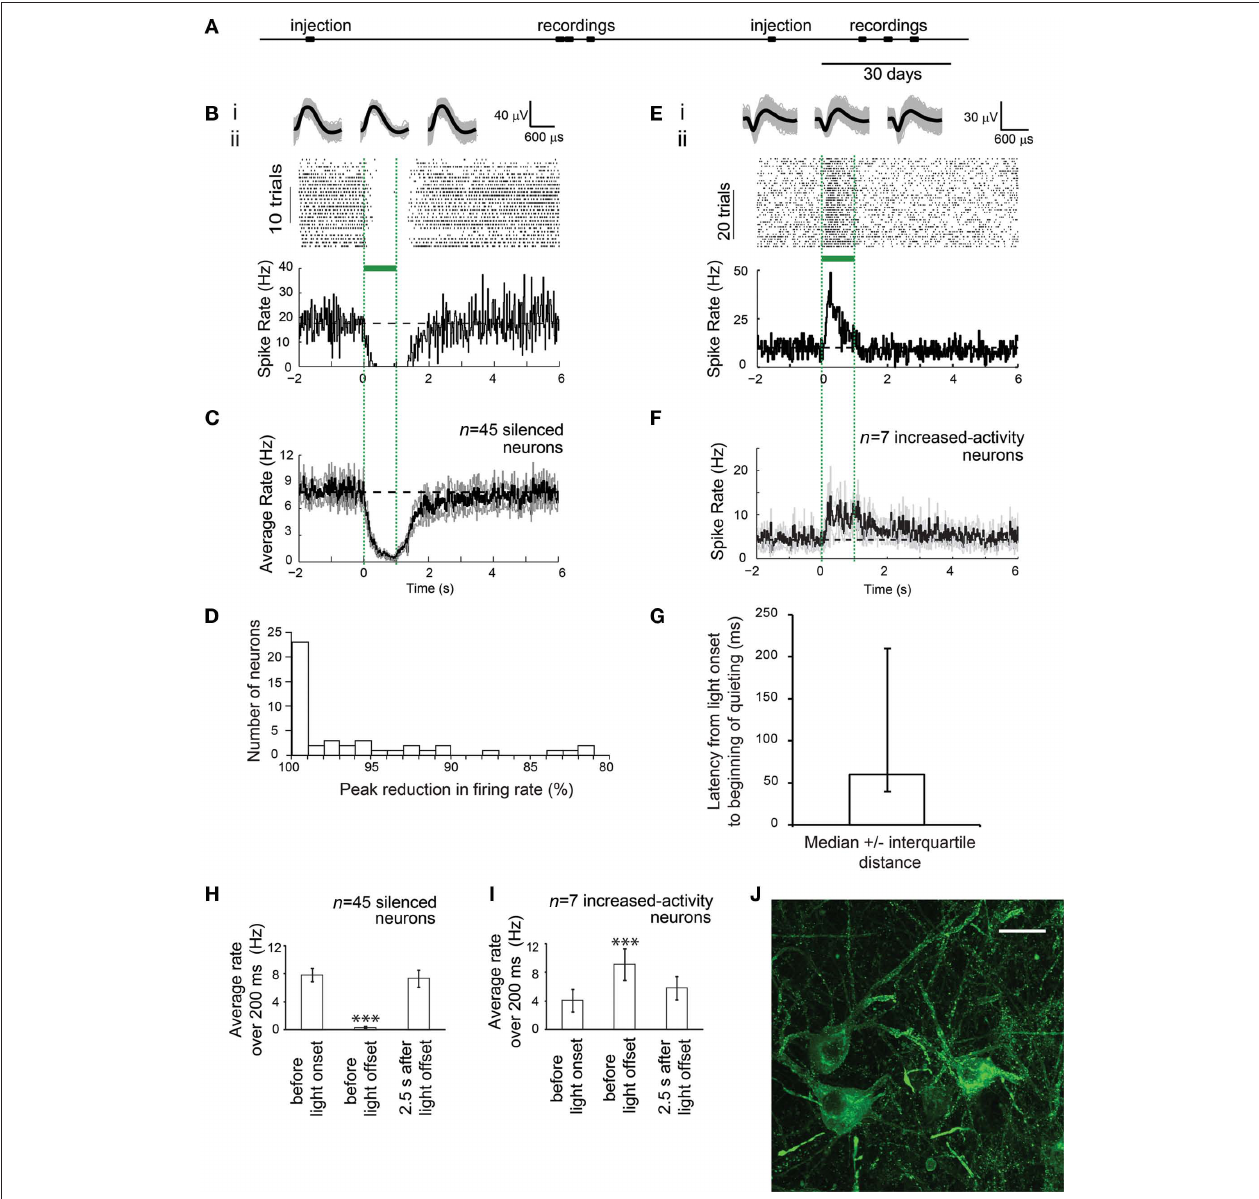
illumination (middle), or after illumination (right). (eii) Neural activity, shown as a spike raster plot (top), and as a histogram of instantaneous firing rate averaged across trials (bottom; bin size 20 ms). (F) Histogram of instantaneous firing rate, averaged across all increased-activity single units recorded upon 200 ms green light exposure, either using raw firing rate data (top), or using firing rate data normalized to baseline firing rate (bottom). Black line, mean; gray lines, mean ± standard error (SE); n = 7 increased-activity single units. (g) Latencies from light onset to the beginning of quieting, for silenced neurons; plotted is median ± interquartile distance ( n = 45 silenced neurons). (H) Summary histogram of all n = 45 silenced neurons, showing firing rates during 200 ms periods, either just before light onset, at the end of the light period (800–1000 m s), or at 2.5 s after light offset. *** p < 0 .005, paired t -test, vs. baseline condition. (i) Summary histogram of all n = 7 increased-activity neurons, showing firing rates during 200 ms periods, either just before light onset, at the end of the light period (800–1000 ms), or at 2.5 s after light offset. (J) Fluorescence image showing lentiviral ArchT-GFP expression in monkey visual cortex, 1 month after lentiviral injection, in monkey B. Scale bar,